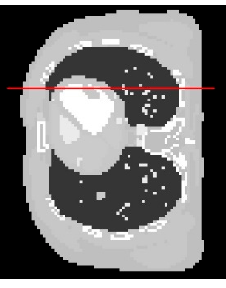
Figure 5. The image profiles of all the results along the horizontal line are plotted. The display window is [0–0.02].